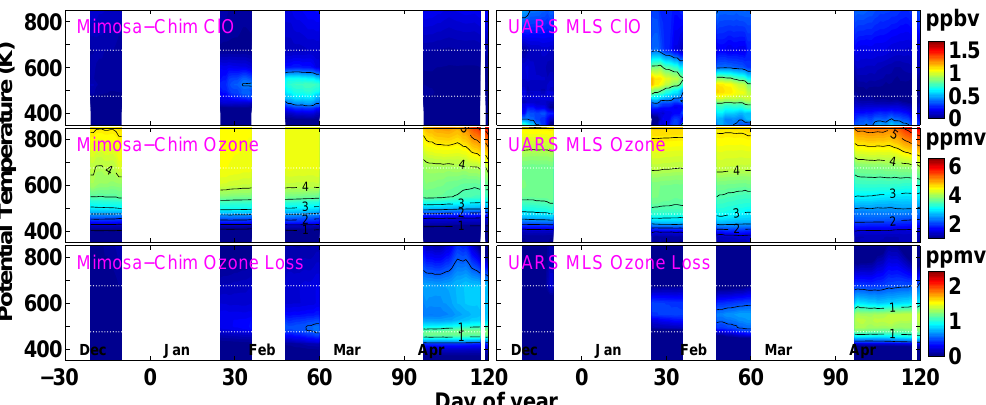
Fig. 4. Temporal evolution of the vertical distribution of ClO (top panel), O 3 (middle panel), and ozone loss (bottom panel) from Mimosa- Chim and UARS MLS for the Arctic winter 1996/1997. The model fields are sampled at the location of MLS observations for each mea- surement inside the vortex and then averaged for the corresponding day. Both data are smoothed for seven days. The Model and MLS ClO coincident profiles are selected for solar zenith angles < 89 ◦ and local time between 10h and 16h. The MLS ClO profiles are bias corrected (see text). The white dotted lines represent 475K and 675K. The blue/red colors show relatively low/high mixing ratios of ClO, O 3 , or ozone loss. The contour interval is 0.5ppmv of O 3 or 0.5ppbv of